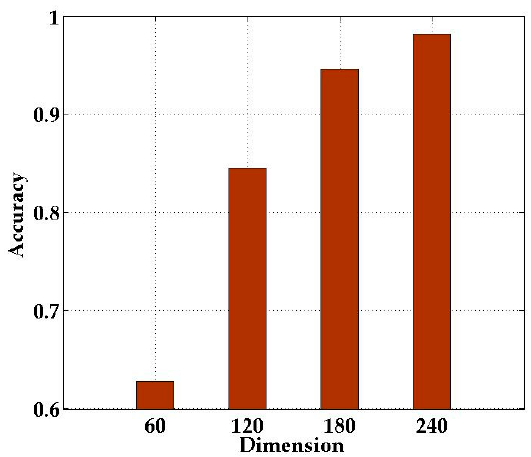
Figure 10. Comparison of classification sample in different dimensions.